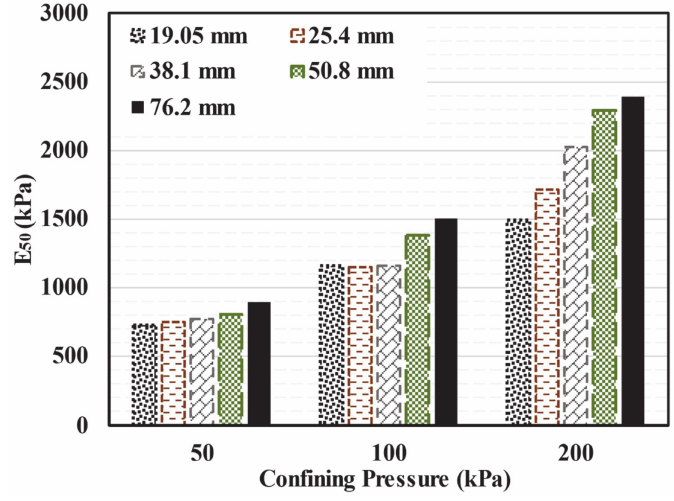
Figure 12. The secant elastic modulus at 10%